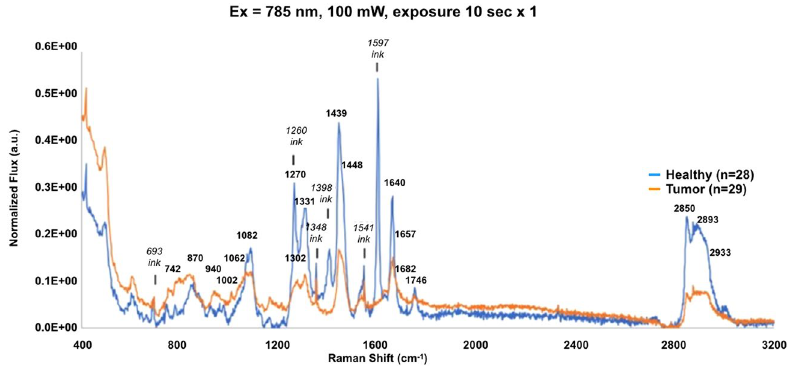
Figure 7. Rapid characterization of tumor and healthy tissue using only the i-Ramani-Raman probe head without microscope. Spectral data were acquired with a single 10 second scan using the bare i-Ramani-Raman probe (785 nm excitation), uncoupled from the microscope, and secured in the probe holder. Spectral data shown are the averages of the 28 healthy and 29 tumor region spectra, where the fluorescence was corrected and the resulting spectra area normalized. Raman bands detecting significant activity from surgical marking ink are noted (693, 1260, 1348, 1398, 1541, and1597 cm − 1 ).